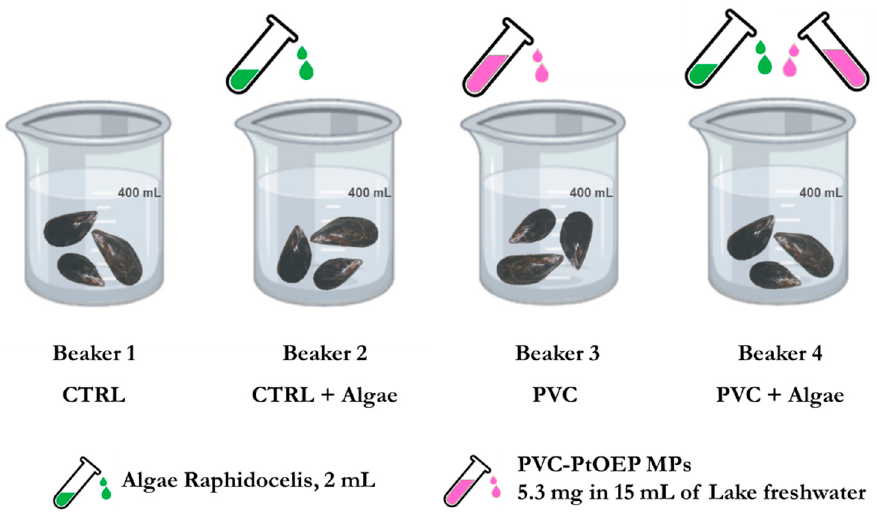
Figure 1. Schematic illustration of the exposure experiments preparation.